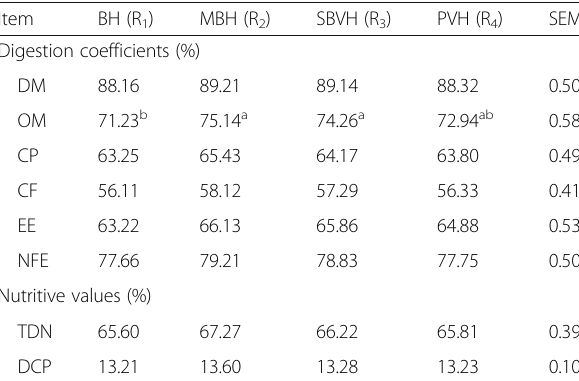
Table 3 Nutrient digestibility and nutritive values of the experimental rations